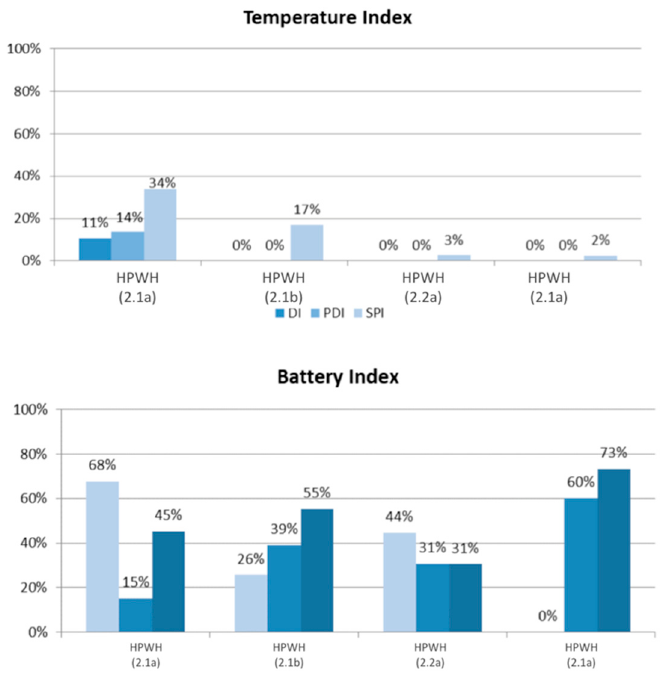
Figure 15. Temperature and battery indices.